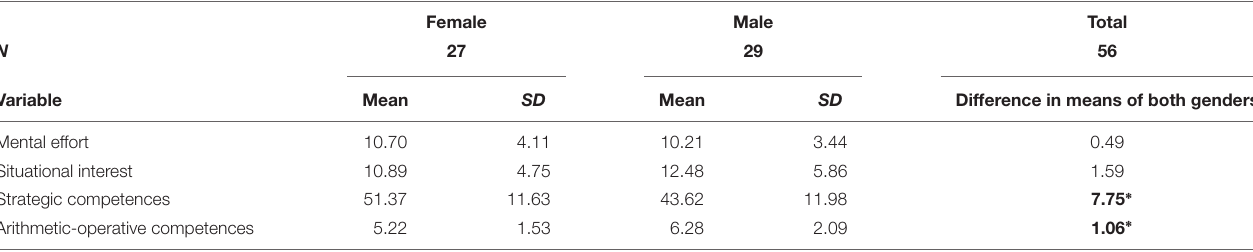
TABLE 2 | Means, standard deviations and difference in means of both genders of the scales Mental Effort, Situational Interest, Strategic Competences, and Arithmetic-Operative Competences of Female and Male Participants.